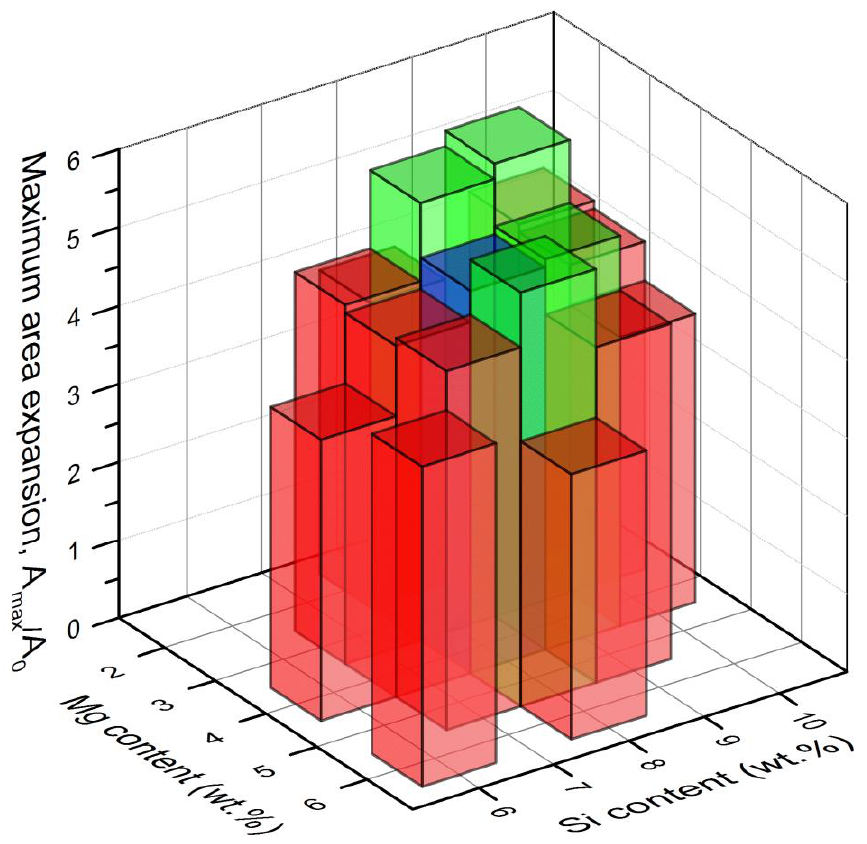
Figure 5. Maximum foam area expansion for varying Mg and Si content. Composition in blue is the reference alloy AlSi8Mg4. Compositions in green show a higher maximum expansion and in red lower ones. Only selected alloys around the reference alloy are plotted for a better overview.